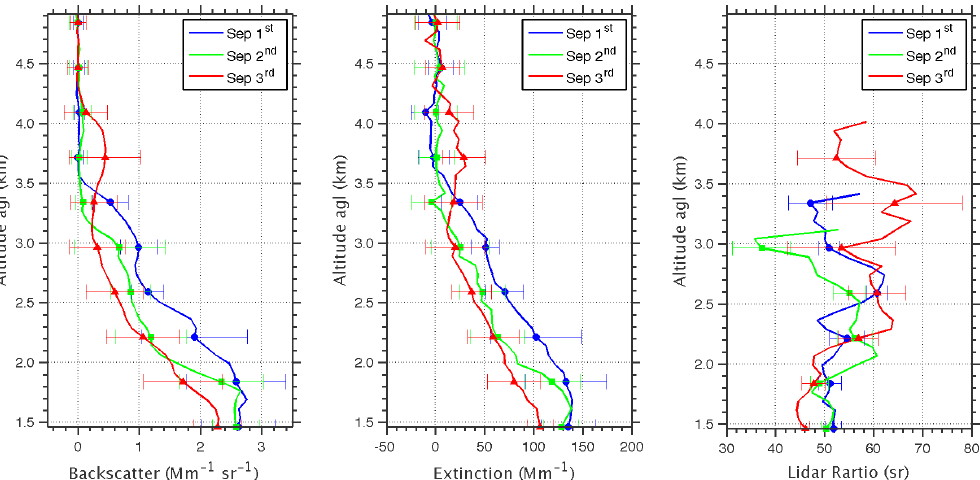
Figure 12. Average aerosol backscatter (left, Mm − 1 sr − 1 ), extinction (middle, Mm − 1 ) and particle lidar ratio (right, sr) obtained from a Raman inversion are shown for days 1, 2 and 3 September 2011.